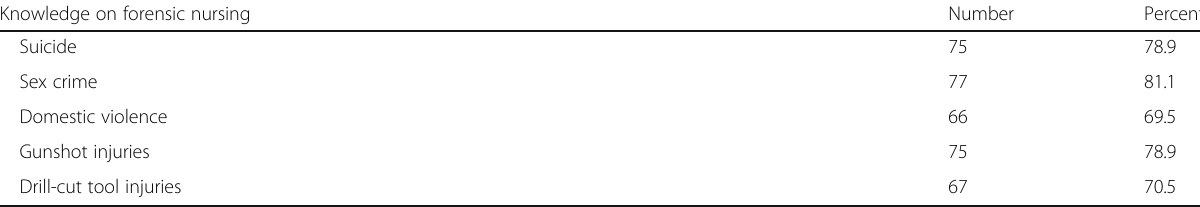
Table 1 Students ’ knowledge about forensic nursing ( N = 95) (Continued) Knowledge on forensic nursing